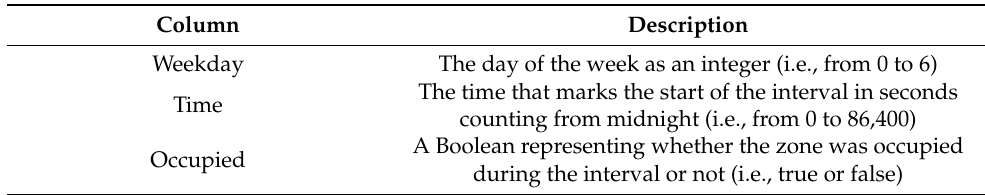
Figure 4. Aerial view of the building and its floorplan. Table 2. Breakdown of the preprocessed